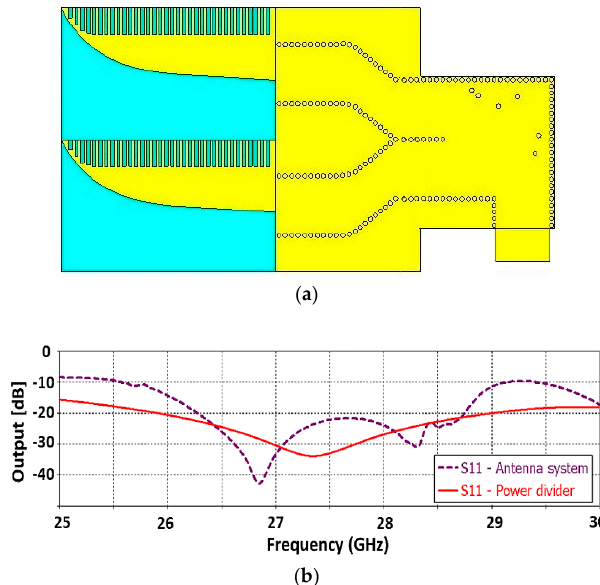
Figure 13. Vivaldi antenna array fed by two-way SIW power divider with 120-degree phase difference; ( a ) structure, ( b ) reflection coefficient of antenna system and s-parameters of two-port power divider.